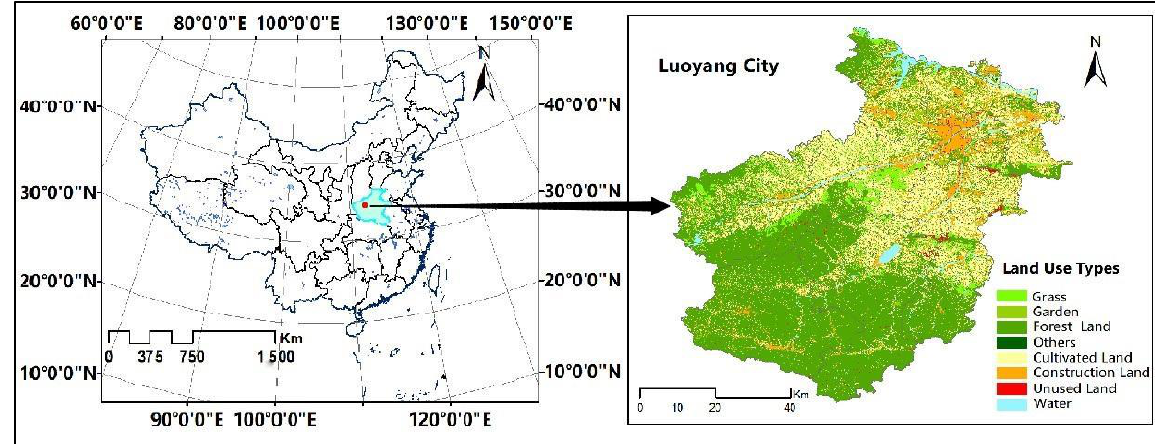
Figure 1. Location and map of Luoyang region.